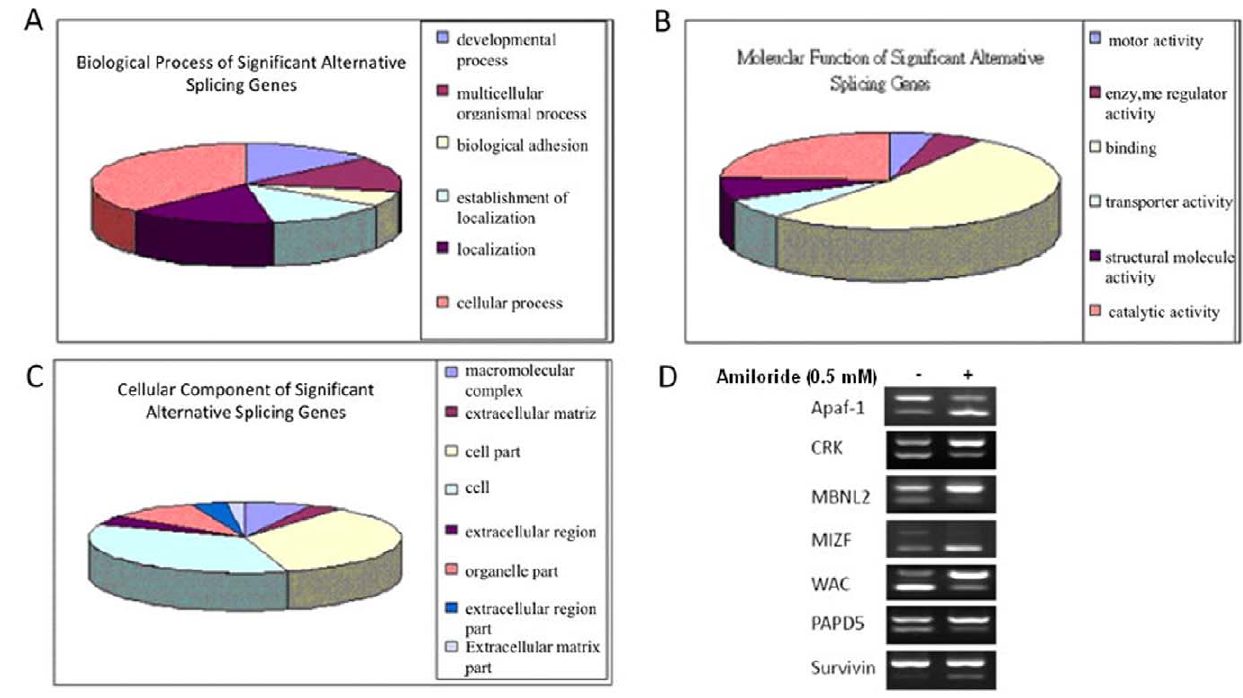
Figure 5. Gene ontology distribution of 495 protein-encoding gene transcripts with amiloride-modulated AS patterns in Huh-7 cells. Bioinformatic analyses of the 495 gene transcripts with amiloride-modified alternative splicing, detected by the genome-wide exon-array measurements, were performed according to gene ontology categories of Biological Process ( A ), Molecular Function ( B ) and Cellular Component ( C ). Amiloride-altered AS patterns of APAF1, CRK,MBNL2, MIZF,WAC, PAPD5 and SU R VIVIN specific protein-encoding gene transcripts detected by the exon- array analysis were validated by RT-PCR of spliced RNA isoforms ( Panel D ).